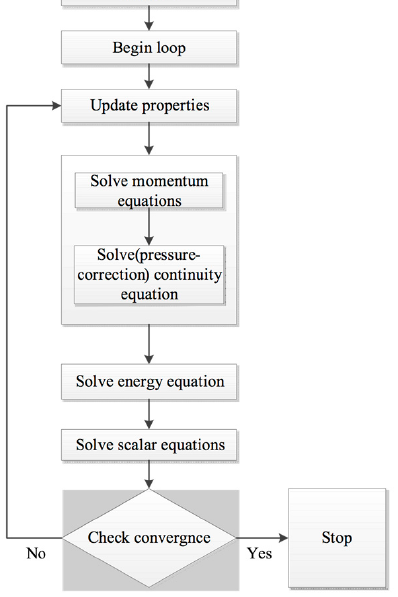
Figure 3. Flow chart of the calculation.